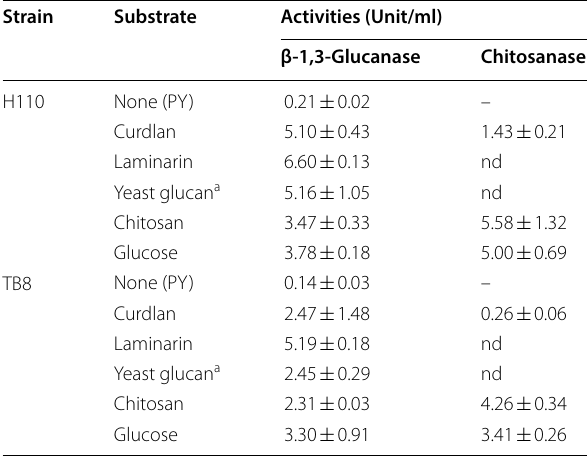
Table 2 β-1,3-Glucanase and